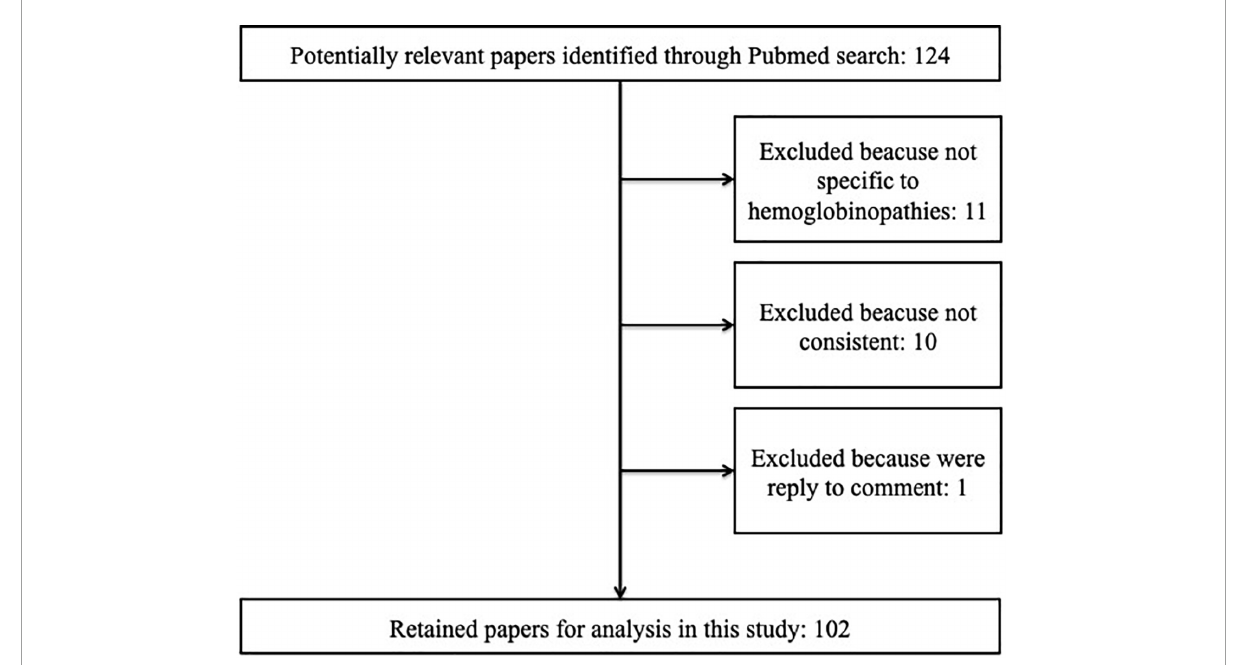
FIGURE1 Review of literature and identification of